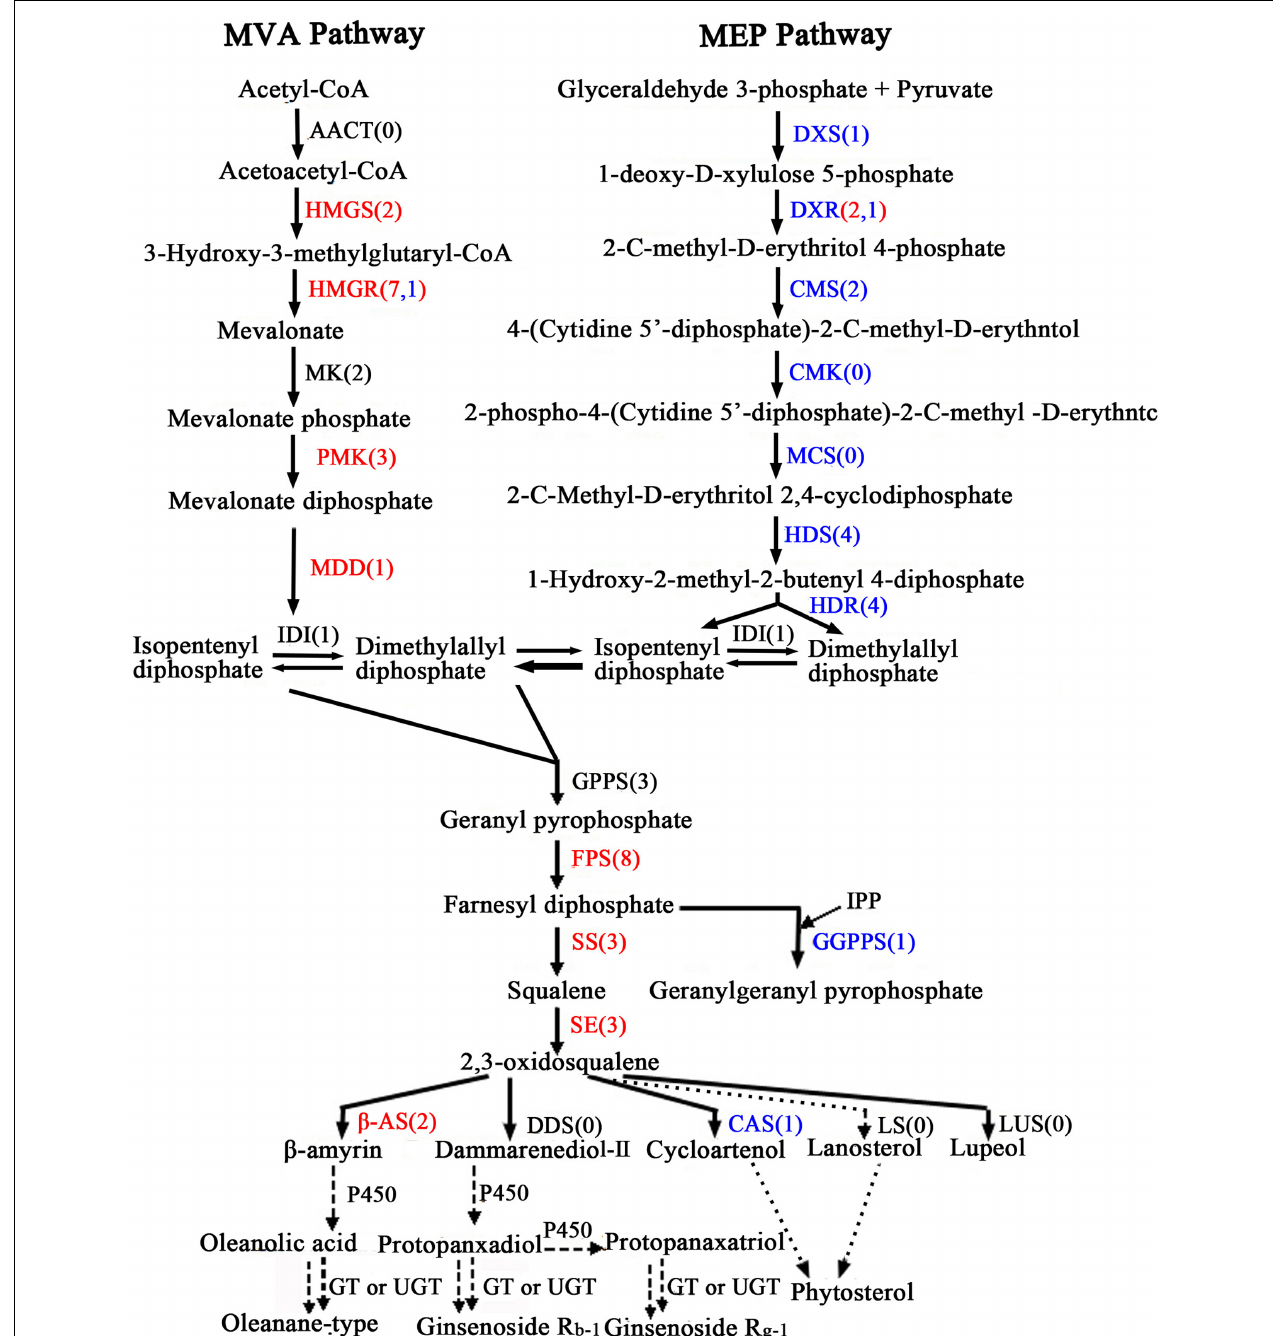
FIGURE 7 | Putative triterpenoid saponins biosynthesis pathway in A. bidentata . Genes in red and blue mean up- and down-regulated in the roots as compared with leaves. Numbers in brackets represent numbers of unigenes in A. bidentata . AACT, acetyl-CoA acetyltransferase; HMGS, HMG-CoA synthase; HMGR, HMG-CoA reductase; MK, mevalonate kinase; PMK, phosphomevalonate kinase; MDD, mevalonate-5-diphosphate decarboxylase; DXS, 1-deoxy- D -xylulose 5-phosphate synthase; DXR, 1-deoxy- D -xylulose 5-phosphate reductoisomerase; CMS, 2-C- methyl- D -erythritol 4-phosphate cytidylyltransferase; CMK, 4-(cytidine 50- diphospho)-2-C-methyl- D -erythritol kinase; MCS, 2-C-methyl- D -erythritol-2,4- cyclodiphosphate synthase; HDS, 4-hydroxy-3-methylbut-2-en-1-yl diphosphate synthase; HDR, 4-hydroxy-3-methylbut-2-enyl diphosphate reductase; IDI, isopentenyl diphosphate isomerase; GPPS, geranyl diphosphate synthase; FPS, farnesyl diphosphatesynthase; GGPPS, geranylgeranyl diphosphate synthase; SS, squalene synthase; SE, squalene epoxidase; DDS, dammarenediol synthase; β -AS, beta-amyrin synthase; CAS, cycloartenol synthase; LS, lanosterol synthase; LUS, lupeol synthesis; P450, cytochrome P450; GT, glycosyltransferase; UGT, UDP-glycosyltransferase.